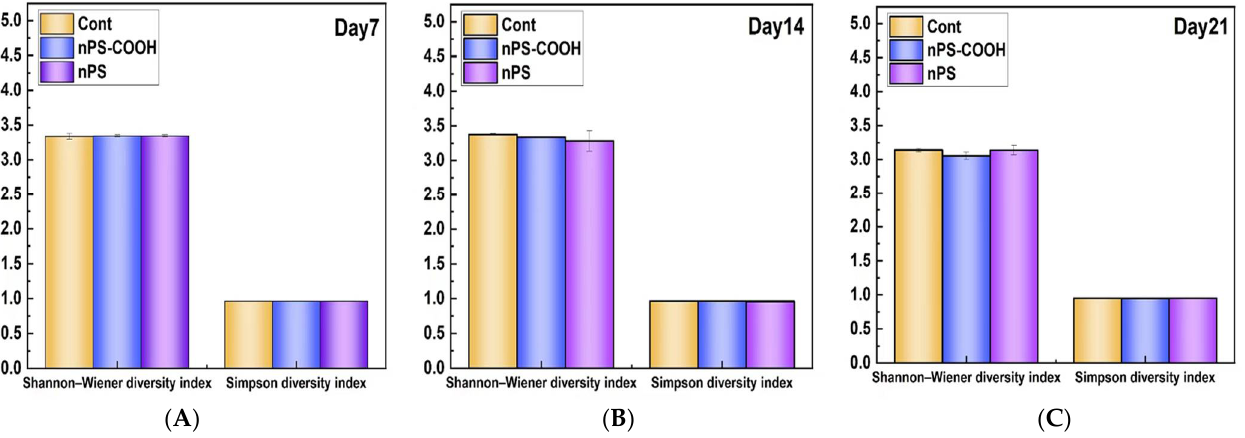
Figure 6. Comparison of metabolic functional diversity indices of biofilms exposed to PS NPs with different surface modifications at day 7 ( A ), day 14 ( B ), and day 21 ( C ) (n = 3).